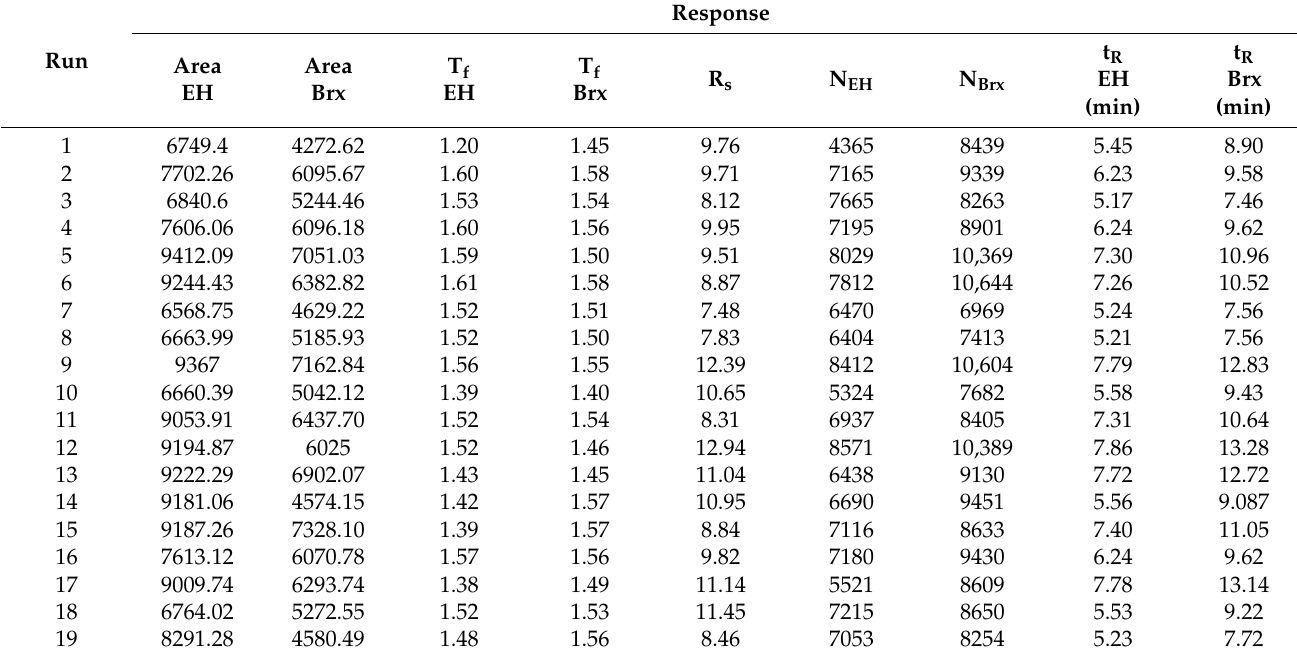
Table 5. Results obtained after conduction of